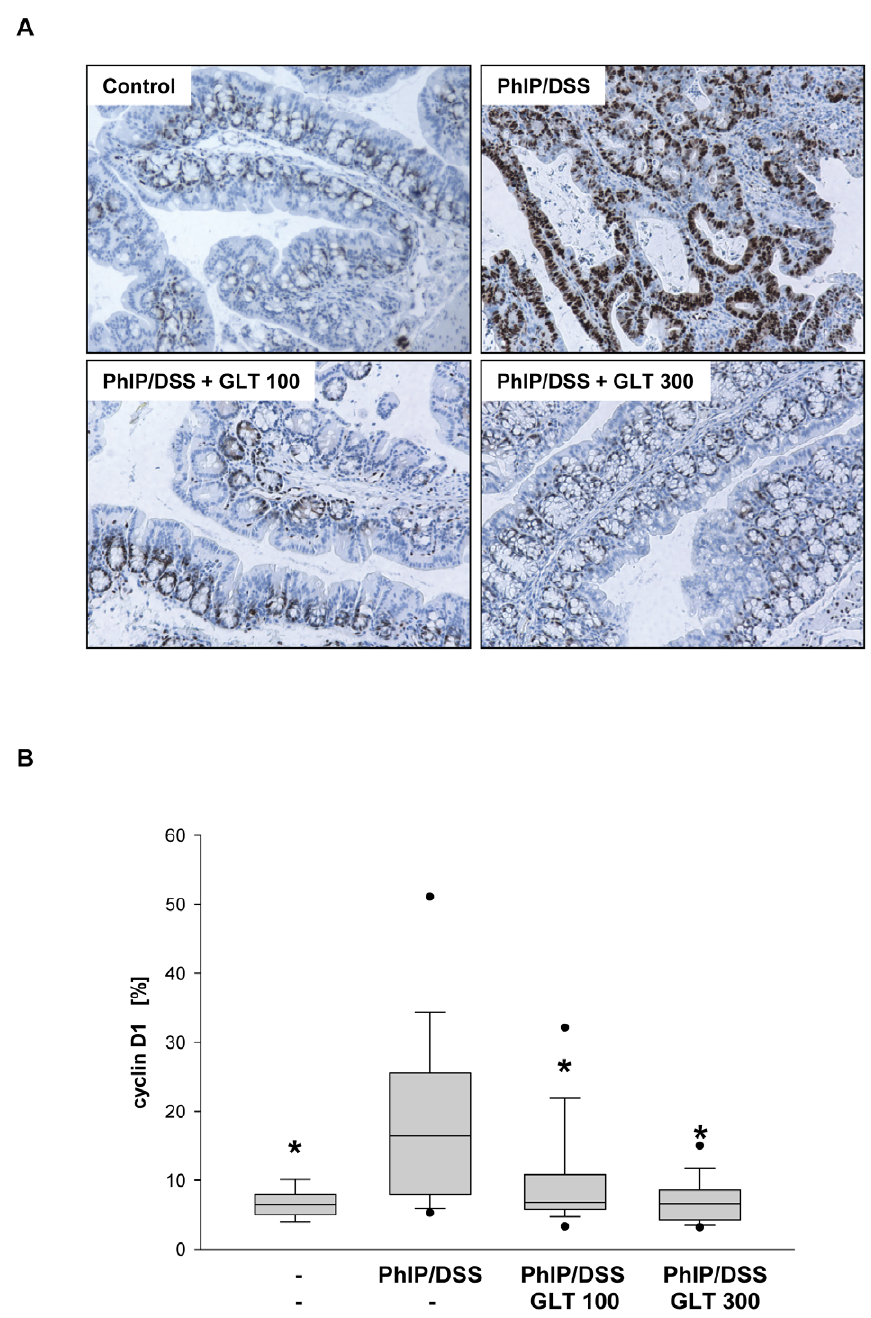
Figure 4. GLT down-regulates expression of cyclin D1 in colon tissue. (A) Immunohistochemistry and (B) quantification of cyclin D1 positive cells were performed as described in Materials and Methods . Box plots represent 5 th /10 th percentiles, horizontal bars represent median values, and whiskers indicate minimum to maximum values. Significant differences (*p , 0.05) were observed among PhIP/DSS vs. control, PhIP/DSS vs PhIP/ DSS + GLT 100, and PhIP/DSS vs. PhIP/DSS + GLT